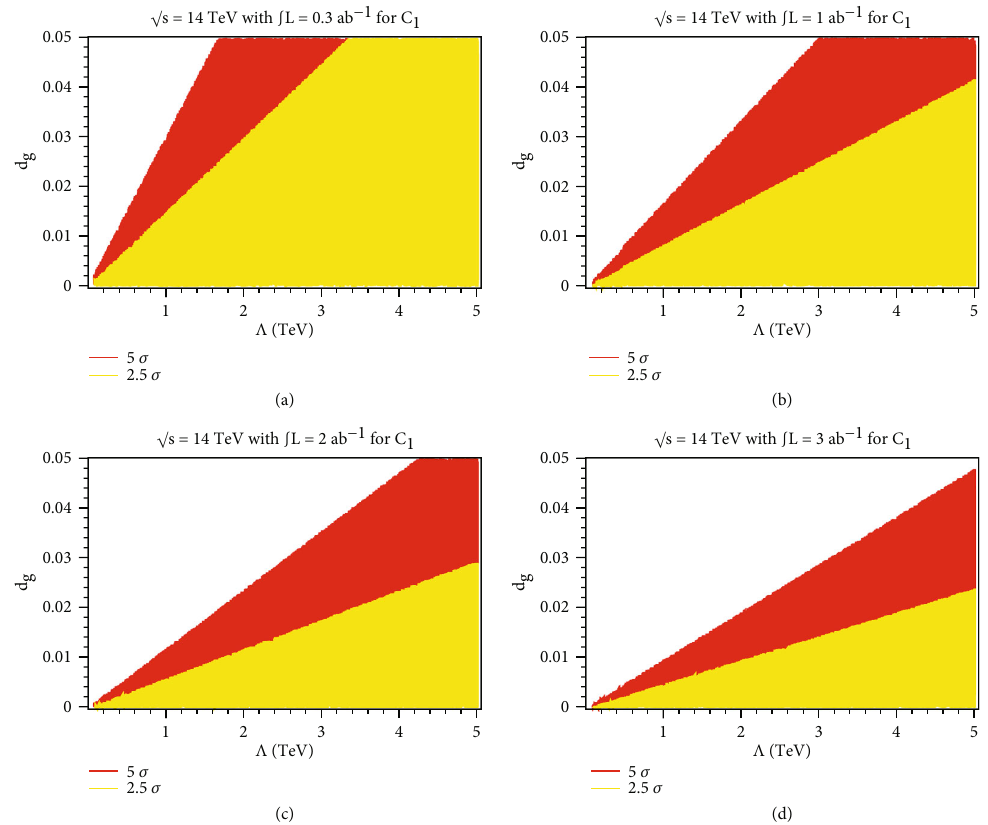
ffiffiffi p at = 14TeV energy at LHC for an integrated luminosity of (a) 0 : 3 ab − 1 , (b) 1 ab − 1 , (c) 2 ab − 1 , and (d) S 1